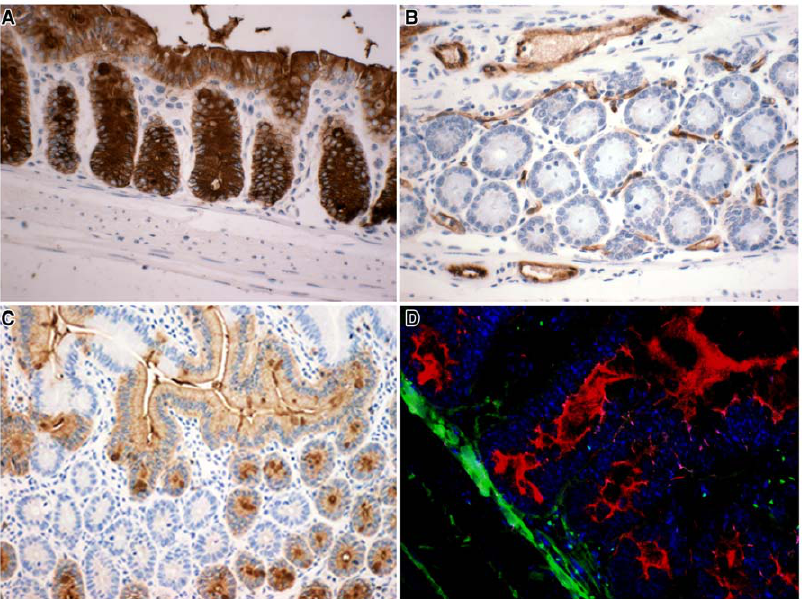
Figure 1. Lectin histochemistry. Dolichos biflorus agglutinin histochemistry of intestinal epithelia revealed by peroxidase-conjugated DBA and DAB in (A) C57 black 6J colon, (B) SWR colon, (C) Small intestine from an aggregation chimaera between both mouse strains. (D) C57 Black 6J small intestine revealed by alkaline phosphatase-conjugated DBA using Vector Red with DAPI nuclear stain in blue subsequently probed for Y chromosomes (green dots) to give 3 signals on the section.